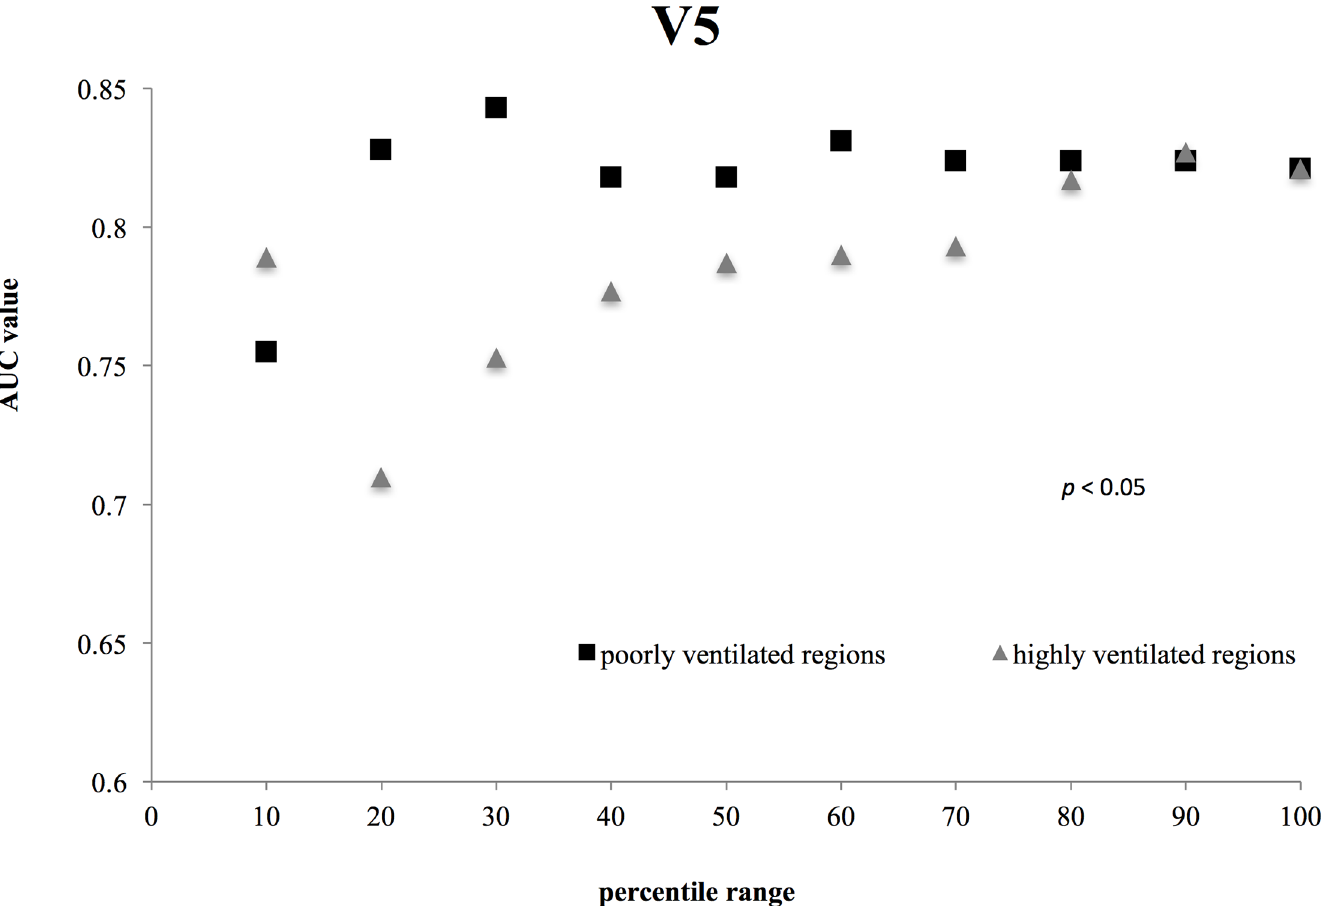
Fig 3. Comparisons between the V5 AUC values for highly and poorly ventilated. The difference in V 5 between poorly and highly ventilated regions was statically significant for each percentile range ( p = 0.0236; Student’s t -test).